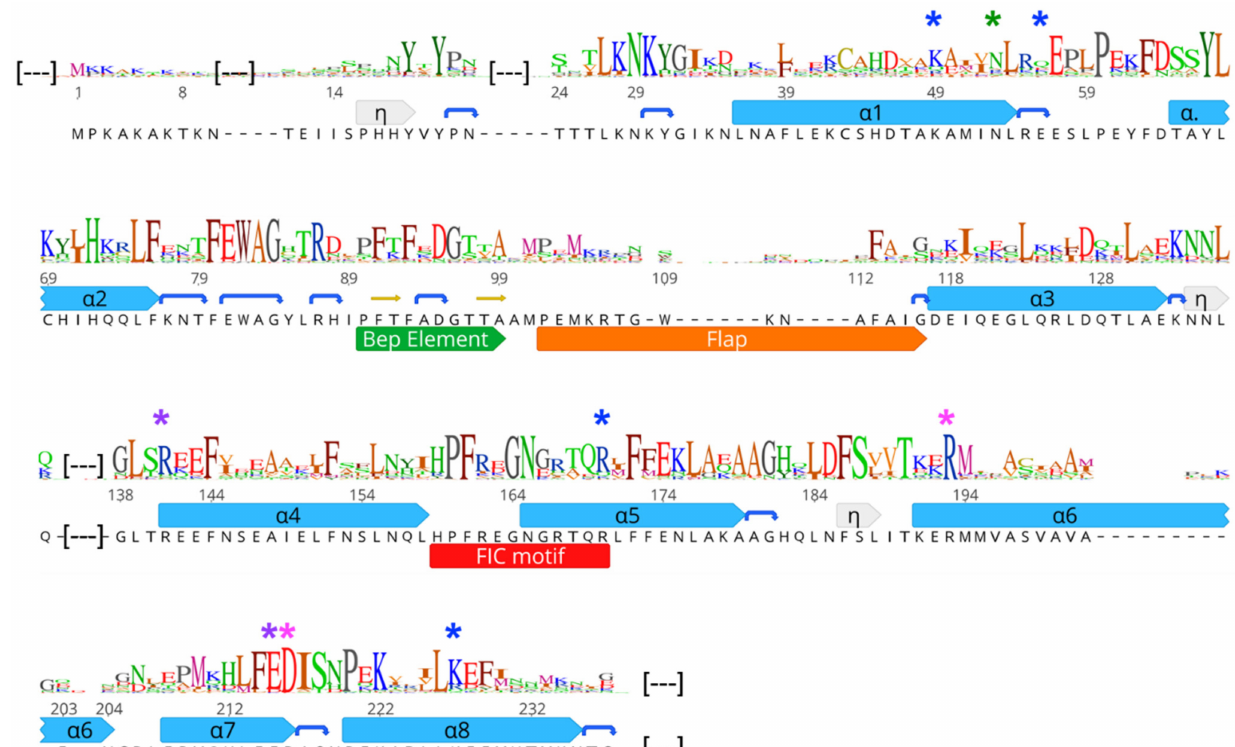
Figure 3. Sequence logo of BepFIC domains derived from the 99 FIC-BID Beps included in the phylogeny given in Figure 1. Sequence, numbering, and secondary structure (helices α 1 to α 8; 3 10 -helices; labeled η ; in grey; strands in yellow; β -turns shown as blue arcs) correspond to Bhe_BepA (PDB: 5NH2). Partners of two salt-bridges are indicated by magenta and pink asterisks, respectively. Residues forming salt-bridges and the asparagine forming the Asn–Asn interaction with the antitoxin Bhe_BiaA are shown as blue and green asterisks, respectively. Functionally important segments are annotated below the sequence. Large gaps in the alignment of Bhe_BepA, due to non-representative insertions in other sequences, have been cropped for convenience and are marked by (—). The logo covering the entire length of FIC-BID Beps proteins is provided in Figure